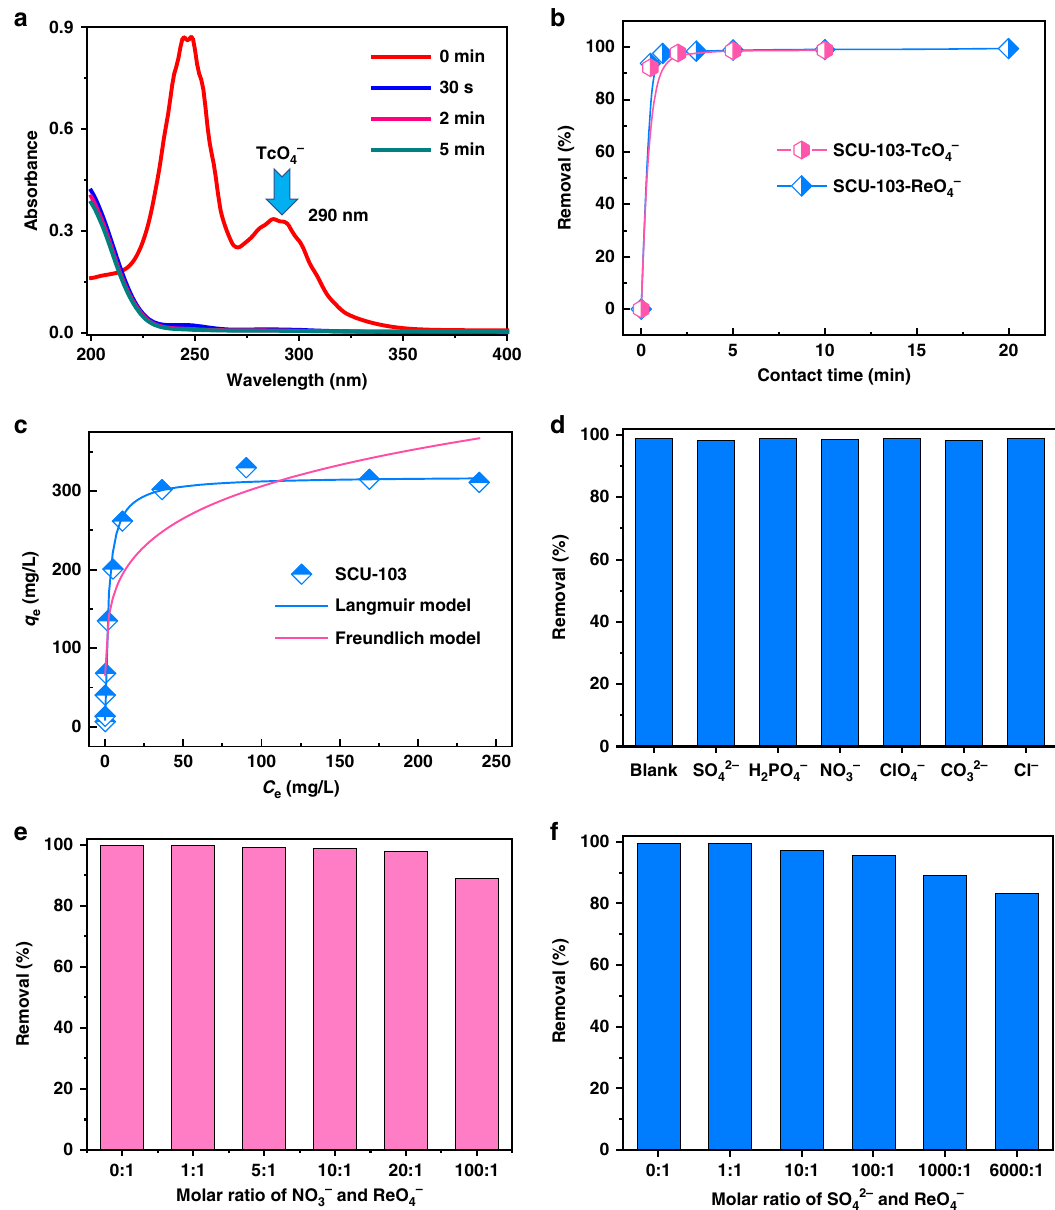
Fig. 3 99 TcO 4 − /ReO 4 − sorption experiment results using SCU-103. a UV − vis spectra of 99 TcO 4 − solution during the anion-exchange with SCU-103. b Sorption kinetics of 99 TcO 4 − and ReO 4 − by SCU-103. c Sorption isotherm of ReO 4 − by SCU-103 (blue line: Langmuir model, pink line: Freundlich model). d Effects of different competing anions on the removal of ReO 4 − by SCU-103. e Effect of excess NO 3 − on the ReO 4 − exchange. f Effect of excess SO 4 2 − on the ReO 4 −